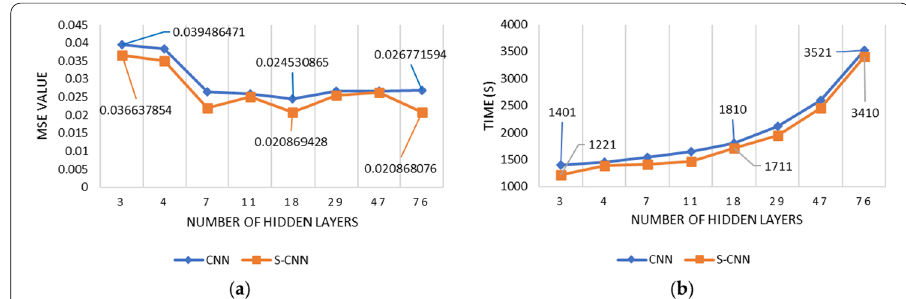
Fig. 7 Comparison of CNN and S-CNN with scenario 1: a MSE; b Processing time